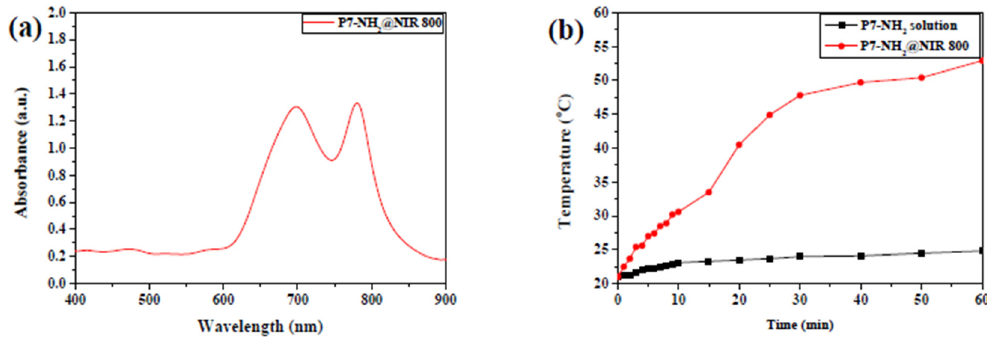
Figure 6. ( a ) Absorbance spectrum of P7-NH 2 @NIR 800 micelles (dilute 5 times, C NIR 800 = 0.07 mg / mL, bonding e ffi ciency = 39.3%). ( b ) Temperature change curves of P7-NH 2 @NIR 800 micelles and P7-NH 2 aqueous solution (1.0 mg / mL) over a period of 60 min under exposure to the NIR light ( λ max = 810 nm, 0.028 W / cm 2 ).